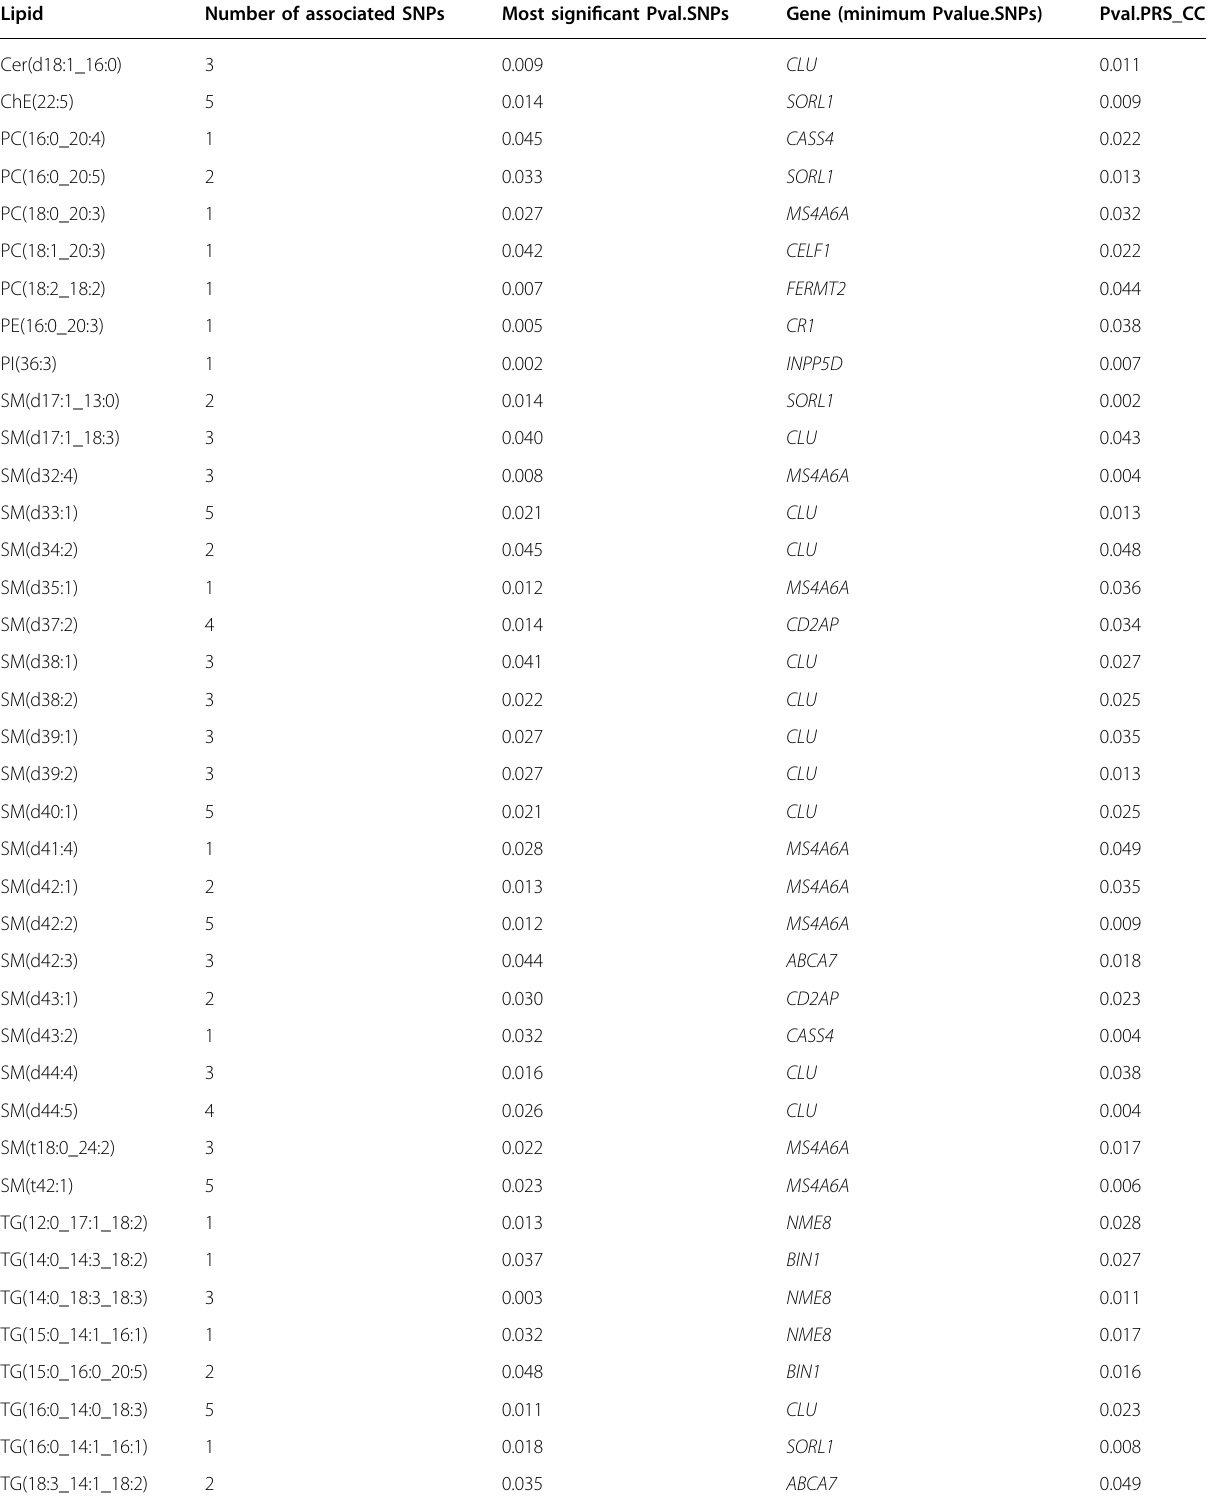
Table 5 Overlap of lipids with signi fi cant association with SNPs and PRS scores. Lipid Number of associated SNPs Most signi fi cant